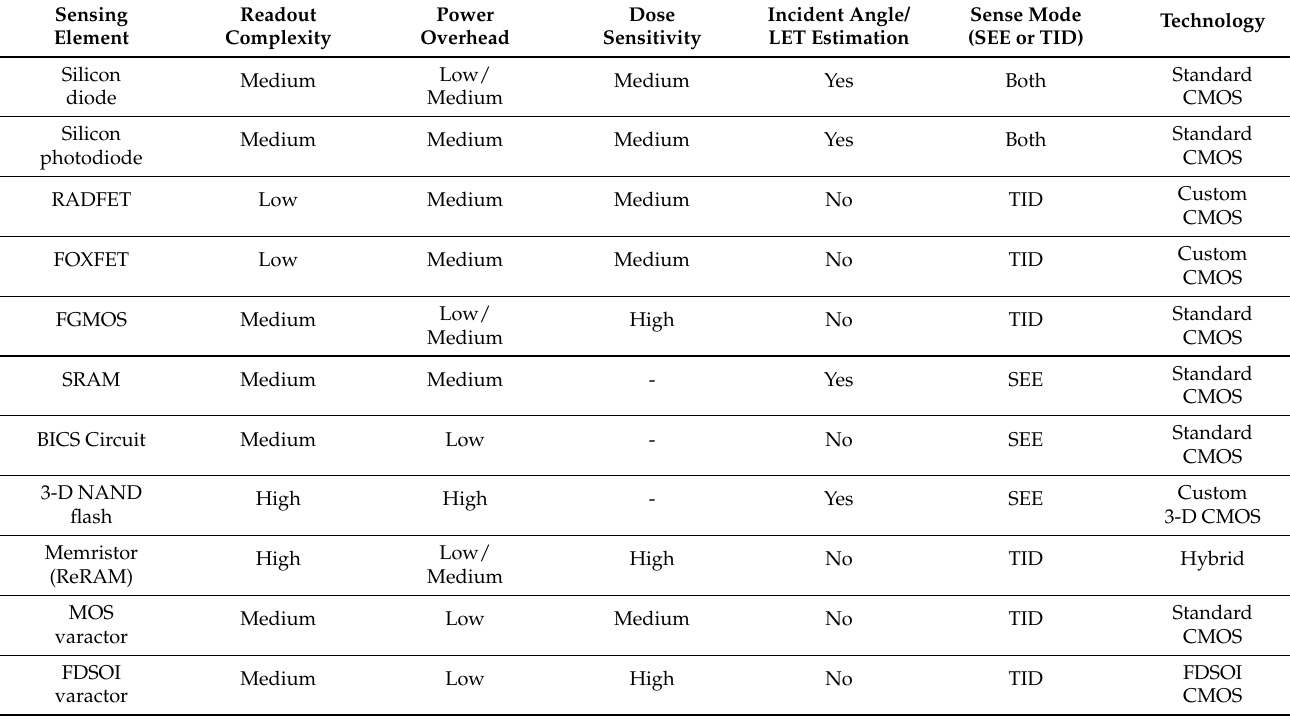
Table 1. Comparison of semiconductor based radiation sensors.